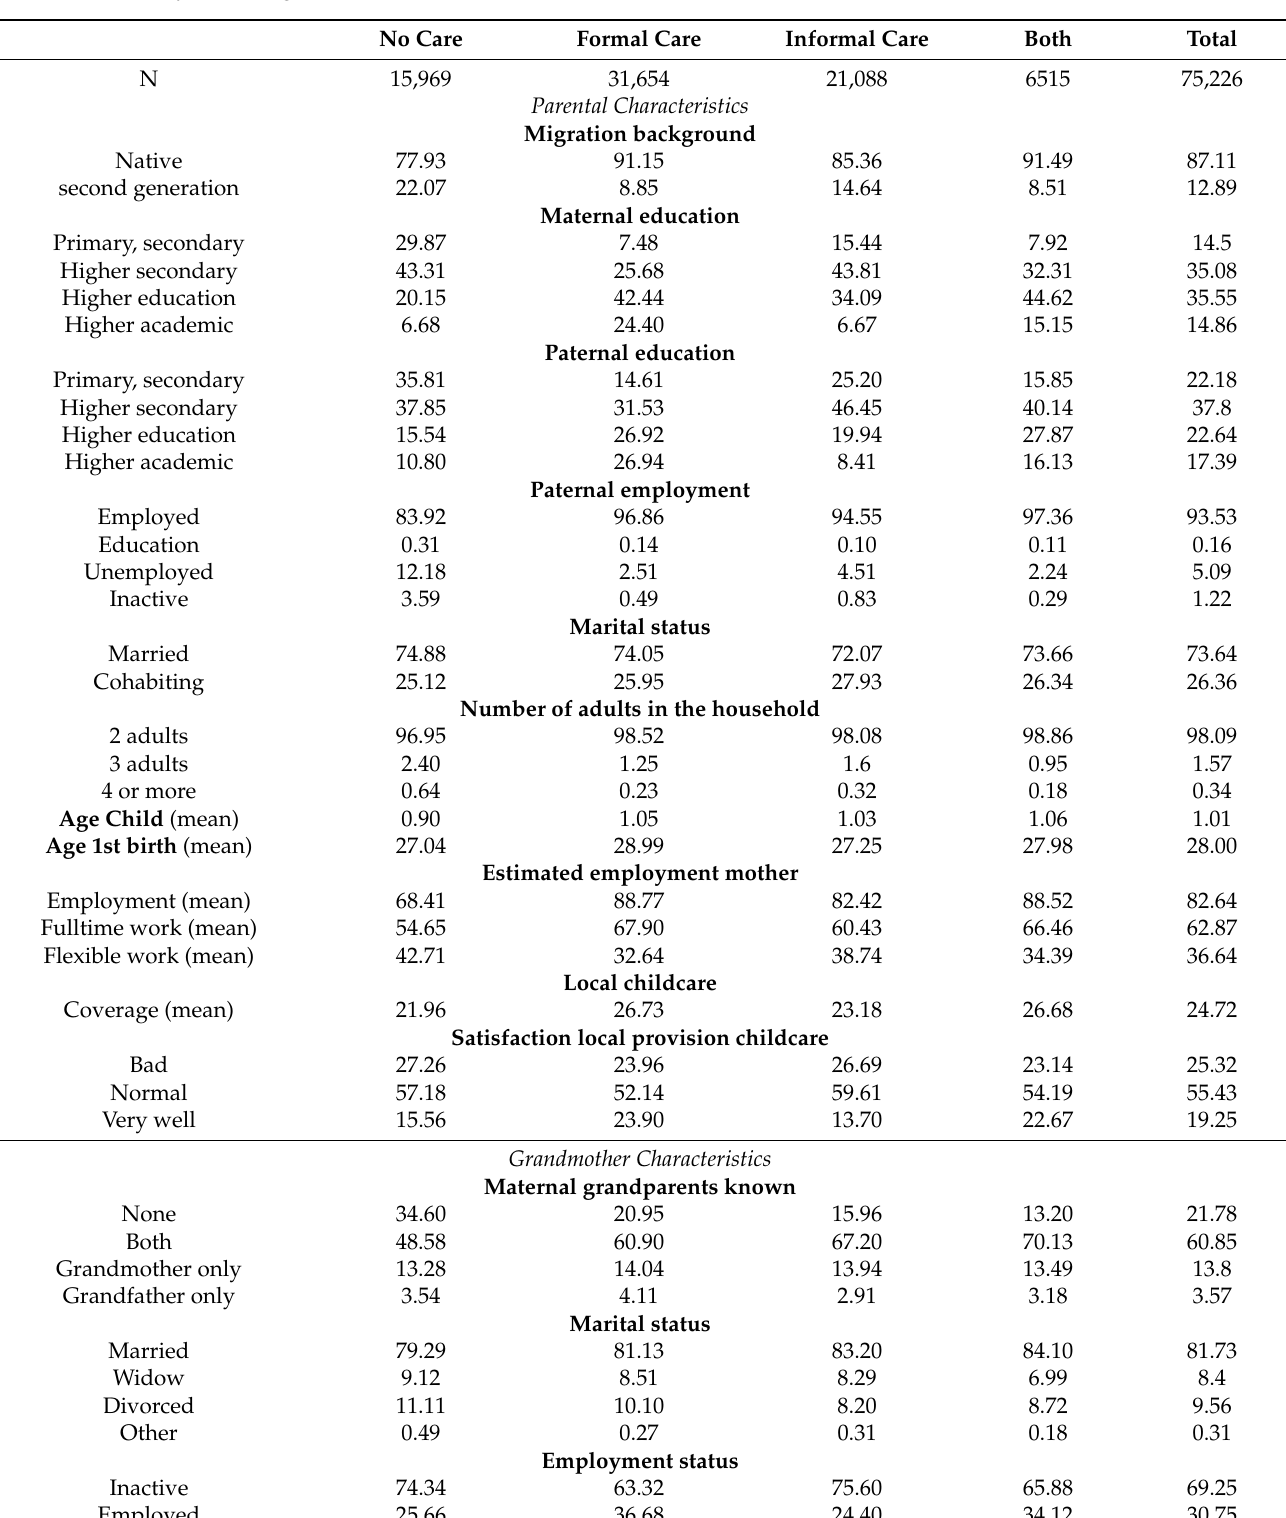
Table 1. Descriptives: characteristics by childcare arrangement, two-parent households with one child, born between 1 May 1999 and 1 July 2001, Belgium,